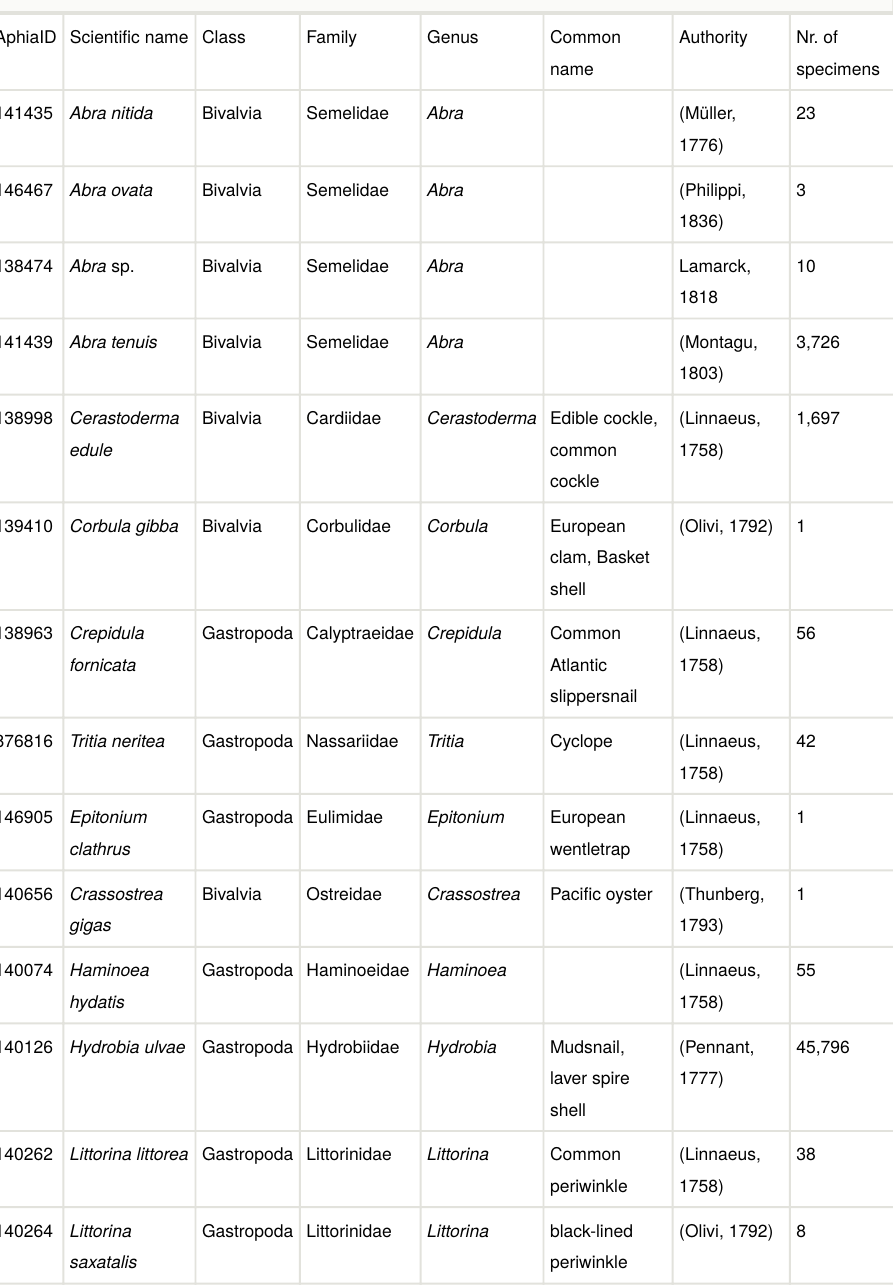
Table 2. Species collected, including total number of specimens in the database, and classi fi cation according to the World Register of